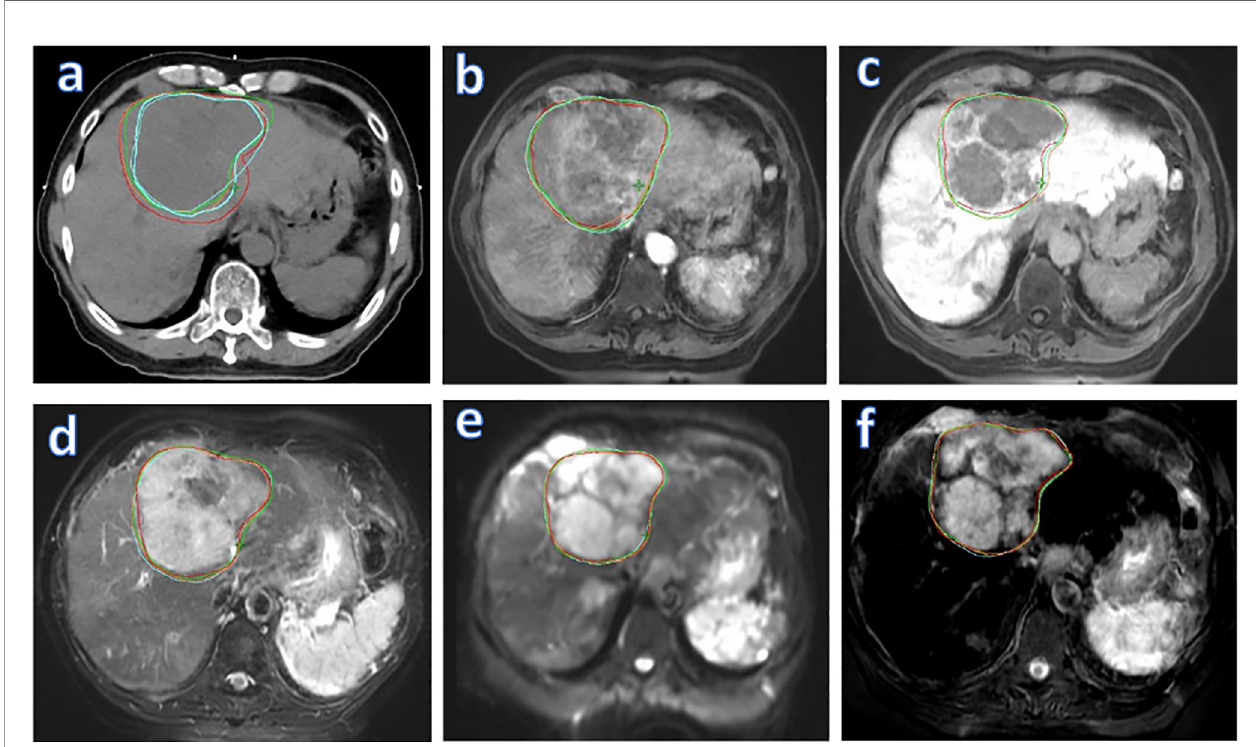
FIGURE 5 | Liver tumor delineation in a representative patient, illustrating different degrees of GTV contouring inter-observer consistency on various images: planning CT (A) , four original MR sets (T1W PP (B) , T1W DP (C) , T2W (D) , and DWI (E) ], and fused MRI (F) . GTV, gross tumor volume; T1W PP , T1-weighted MRI at portal-venous phase; T1W DP , T1-weighted MRI at 19-min delayed phase; T2W, T2-weighted; DWI, diffusion-weighted